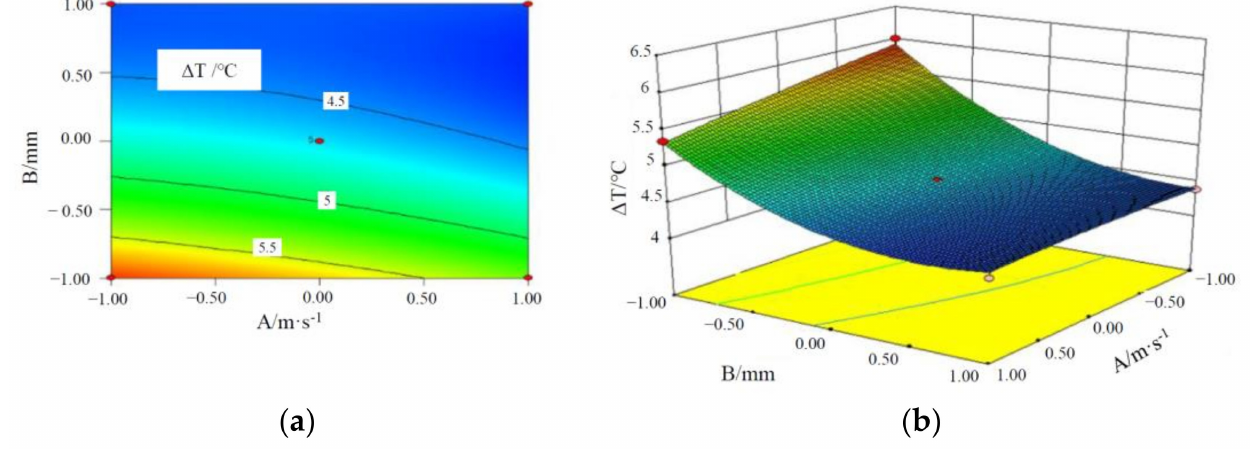
Figure 5. Contours and response surface of the impact of liquid flow rate and CPCM thickness on the maximum temperature difference. ( a ) Contours; ( b ) response